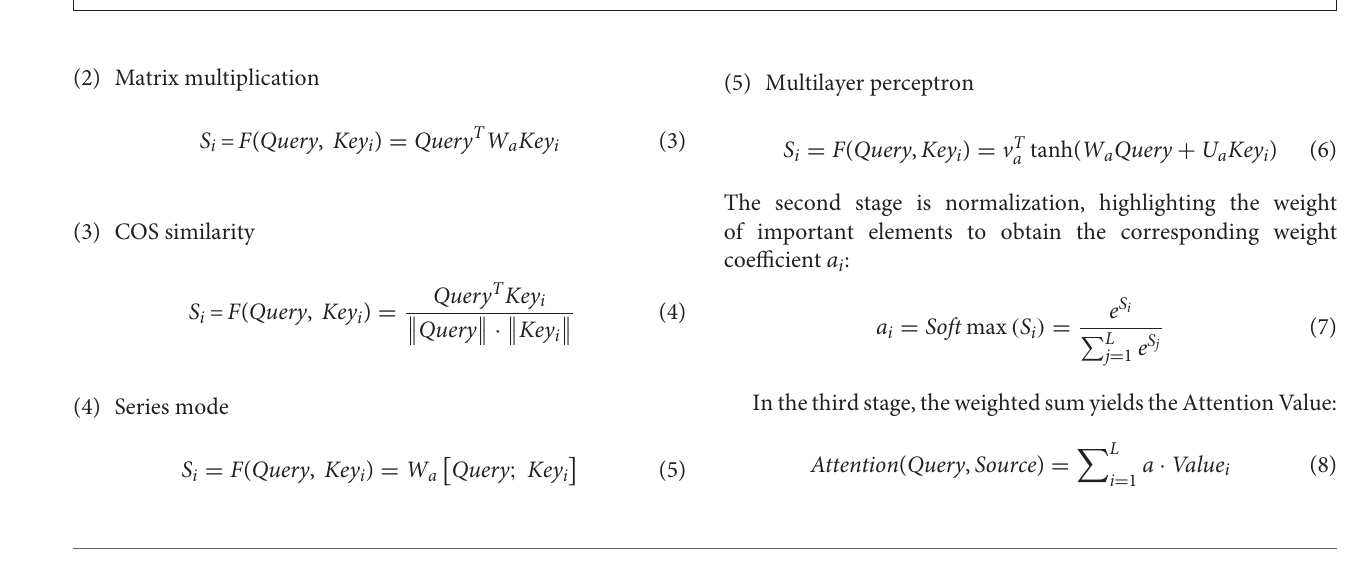
FIGURE 2 | Specific calculation process of attention